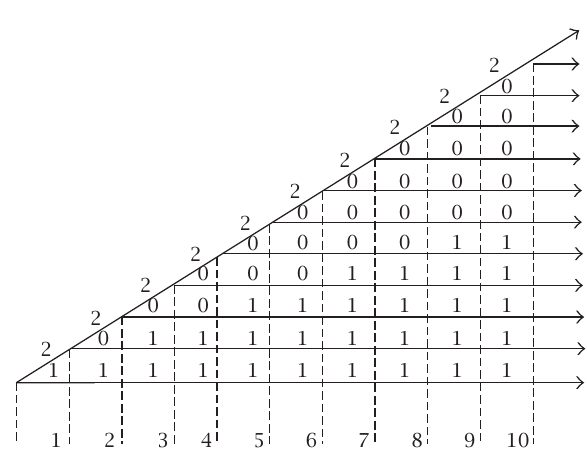
Figure 3.2. State-space diagram for Example